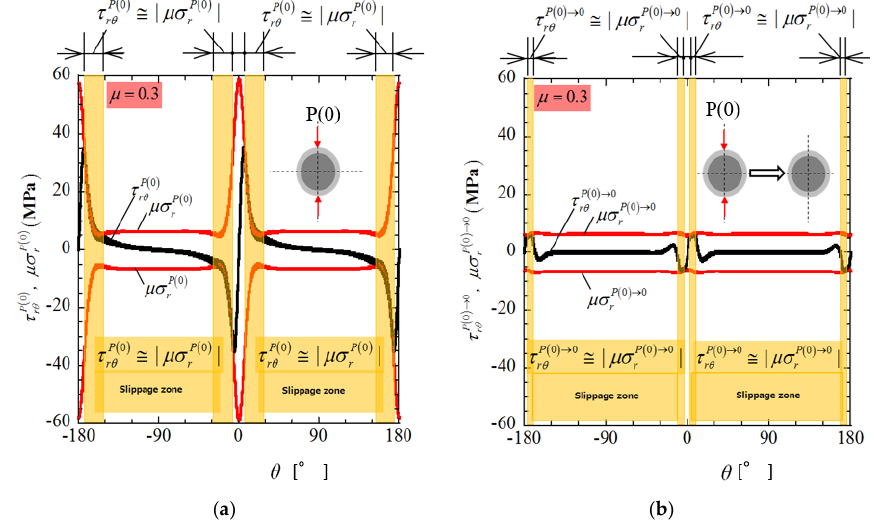
Figure 13. Comparison of slippage zone under the initial loading P ( 0 ) and slippage zone after removing the initial loading P ( 0 ) → 0, ( a ) under the initial loading P ( 0 ) ; ( b ) after removing the initial loading P ( 0 ) .